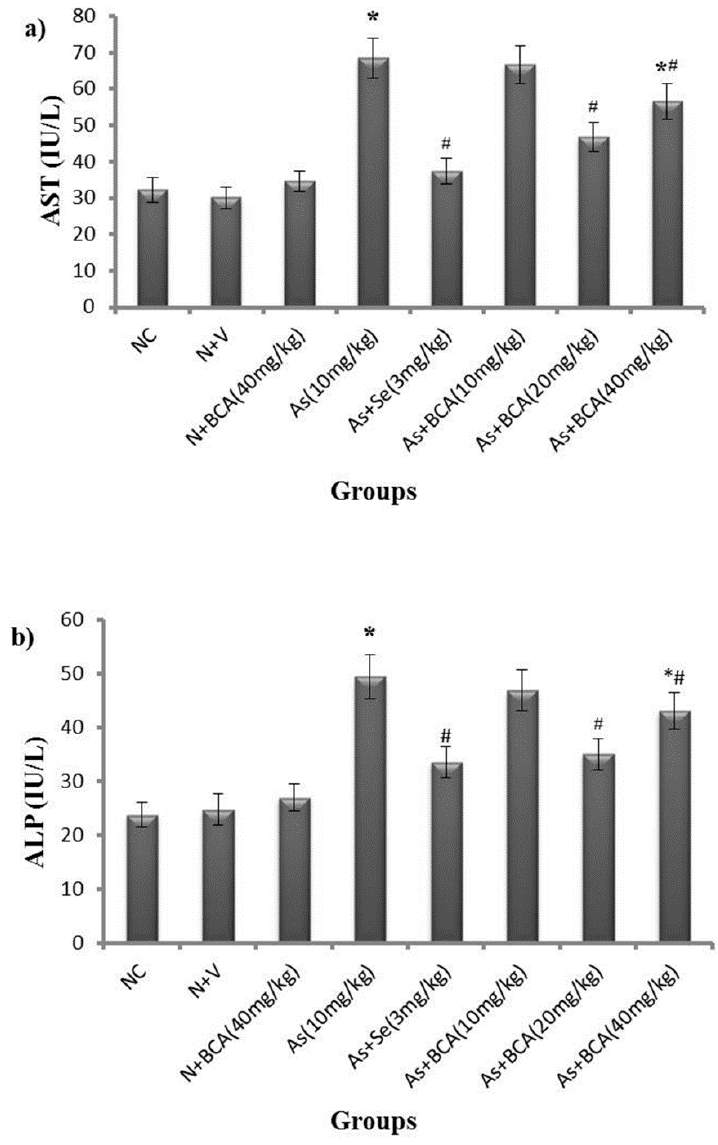
Figure 1. Differences between the activities of plasma AST ( a ) and ALT ( b ) in normal control and experimental rats. All values are expressed as means ± SD ( n = 6). NC: Normal control, N: Normal, V: Vehicle, BCA: Biochanin A, As: Arsenic, Se: Selenium.* p < 0.05 compared to normal control rats. # p < 0.05 compared to arsenic-treated rats.